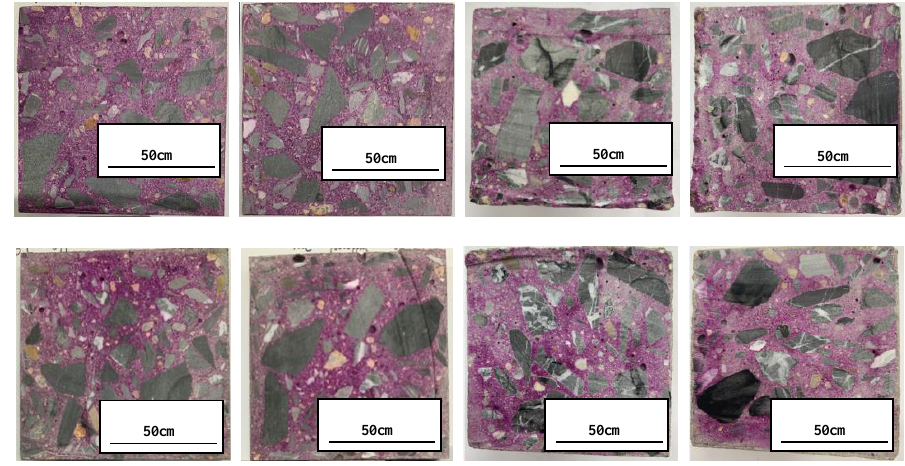
Figure 7. Depth of neutralization of concrete at 180 days.